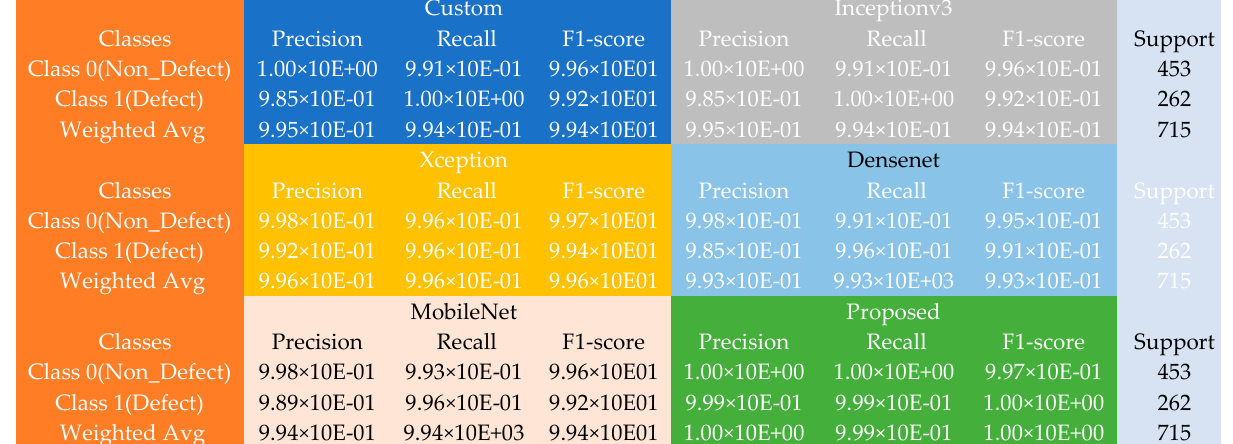
Figure 4. The confusion matrix table using the casting dataset.